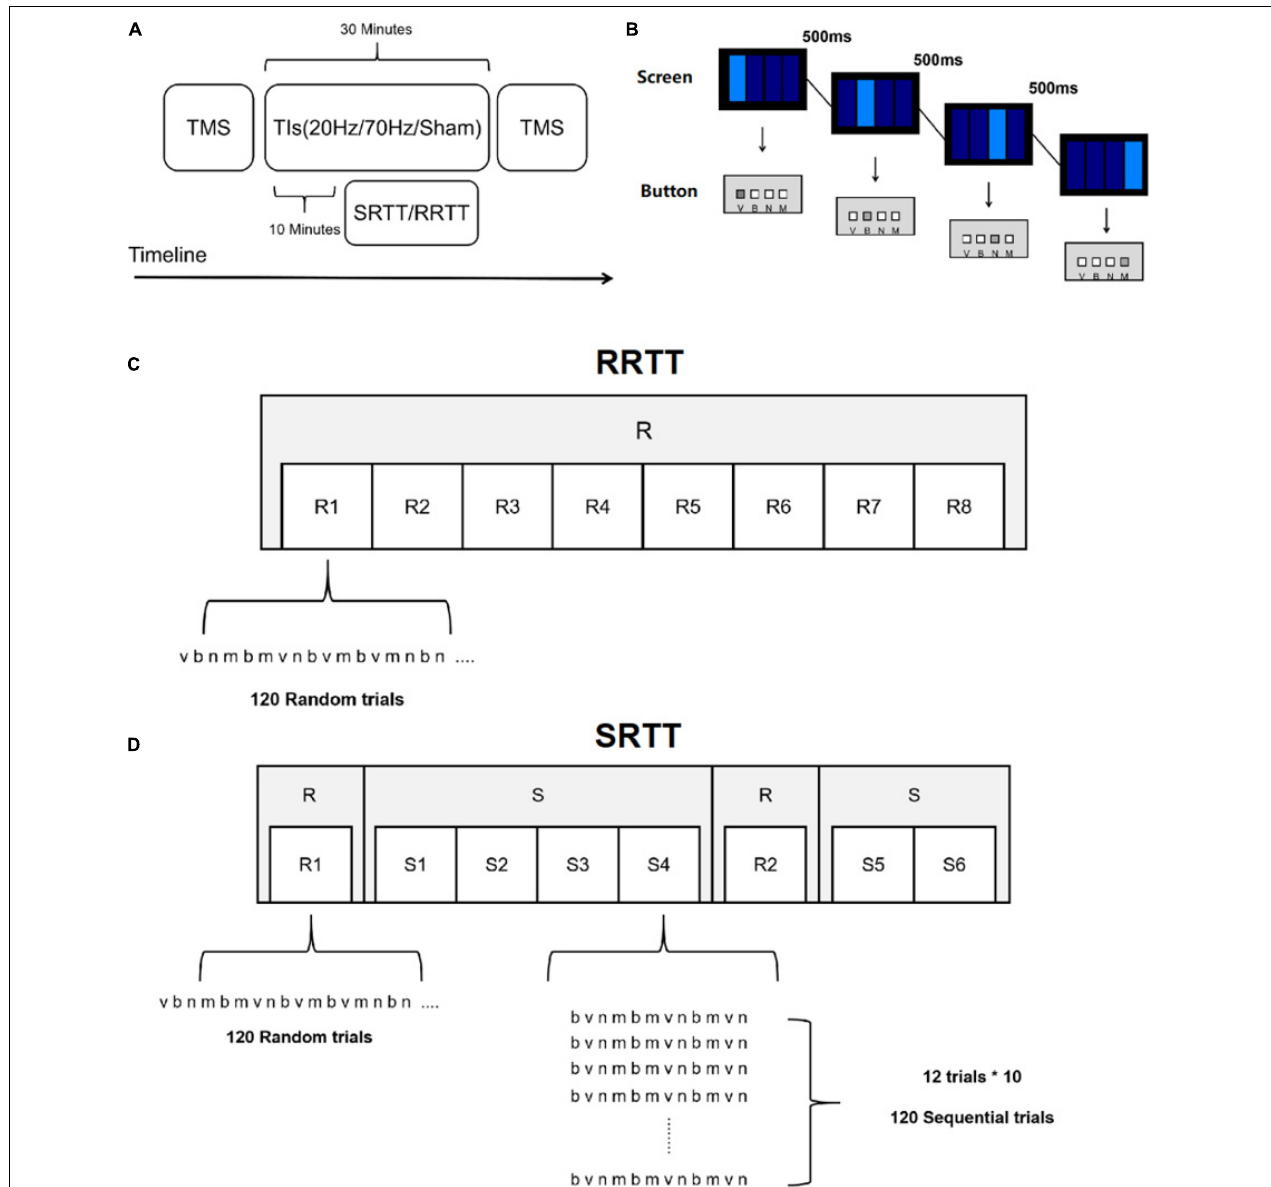
FIGURE 1 | Experimental design and motor tasks. (A) The experimental procedures. (B) Motor task implemented in our experiments. (C) RRTT. (D) SRTT. In R blocks, there were three 12-item (bnmvnbmnvbvm, nvnmbvmnbmvb, mvbmnbnvmbvn) sequences with comparable difficulty for each experimental session in a counterbalanced